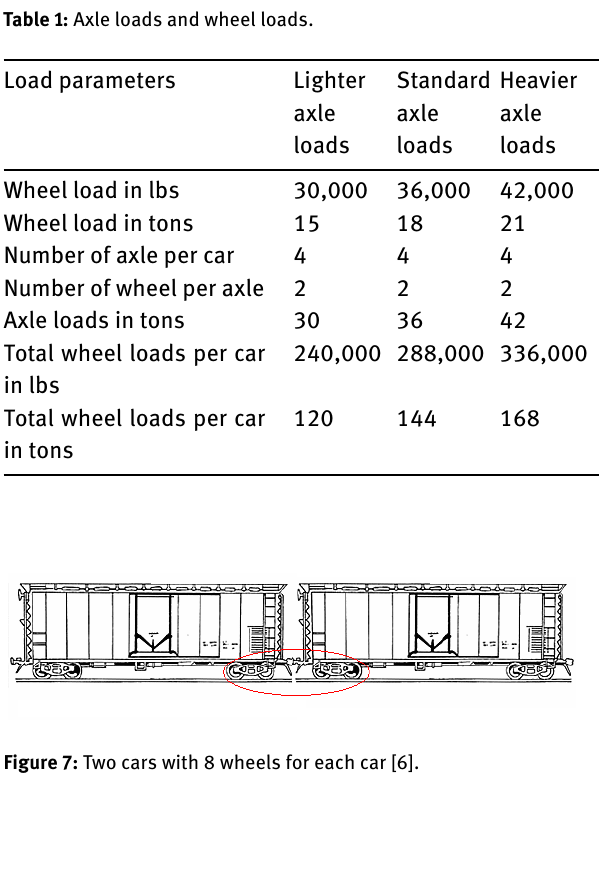
Table 2: Load repetitions through seasons.